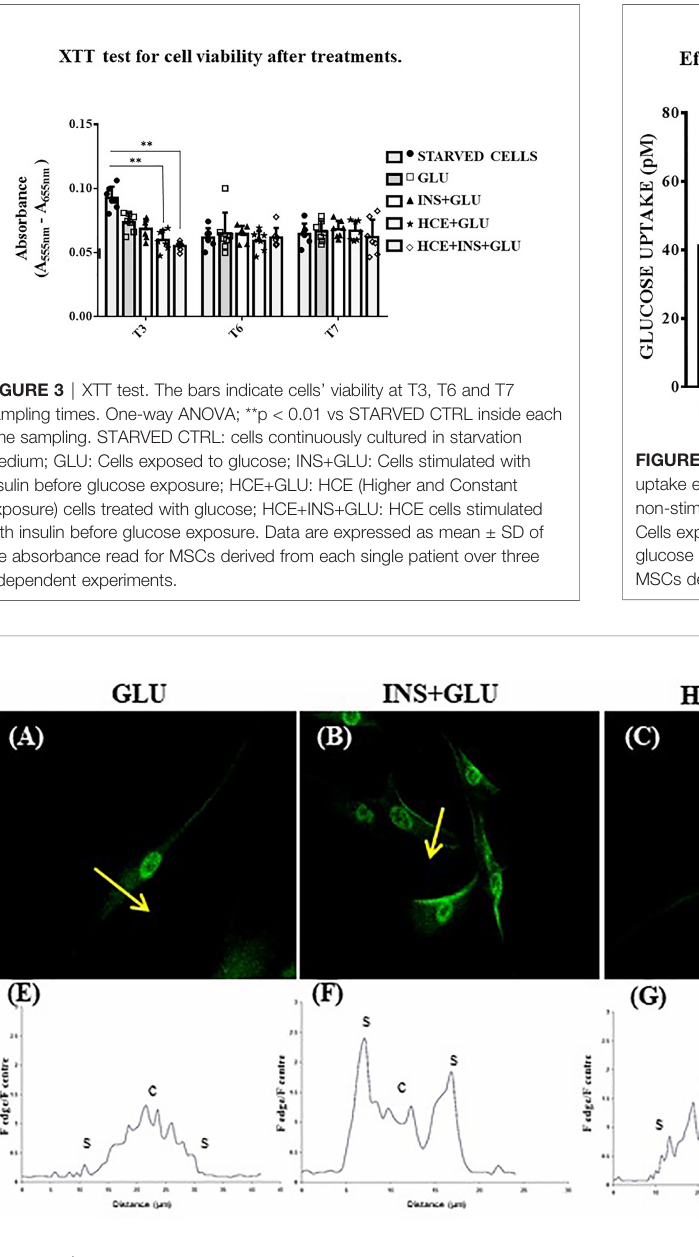
FIGURE 5 | GLUT4 translocation. Representative confocal images of GLUT4 in MSCs derived from the seven patients and stimulated (B, D) or not (A, C) with insulin and exposed to 500nM of GCs (C, D) . The graphs (E – H) show the fl uorescence ratio between the edge and the centre of the cell; yellow arrows indicate the portion of cell subjected to analysis. GLU: Cells exposed to glucose; INS+GLU: Cells stimulated with insulin before glucose exposure; HCE+GLU: HCE (Higher and Constant Exposure) cells treated with glucose; HCE+INS+GLU: HCE cells stimulated with insulin before glucose